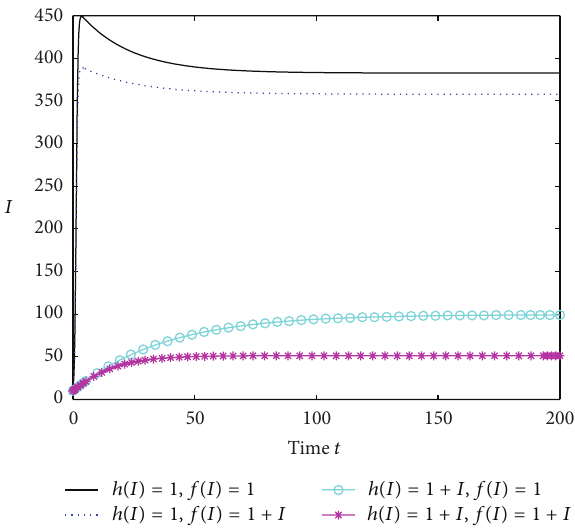
Figure 7: An illustration of the impact of different incidence rates and vaccination probabilities on 𝐼 given in Example